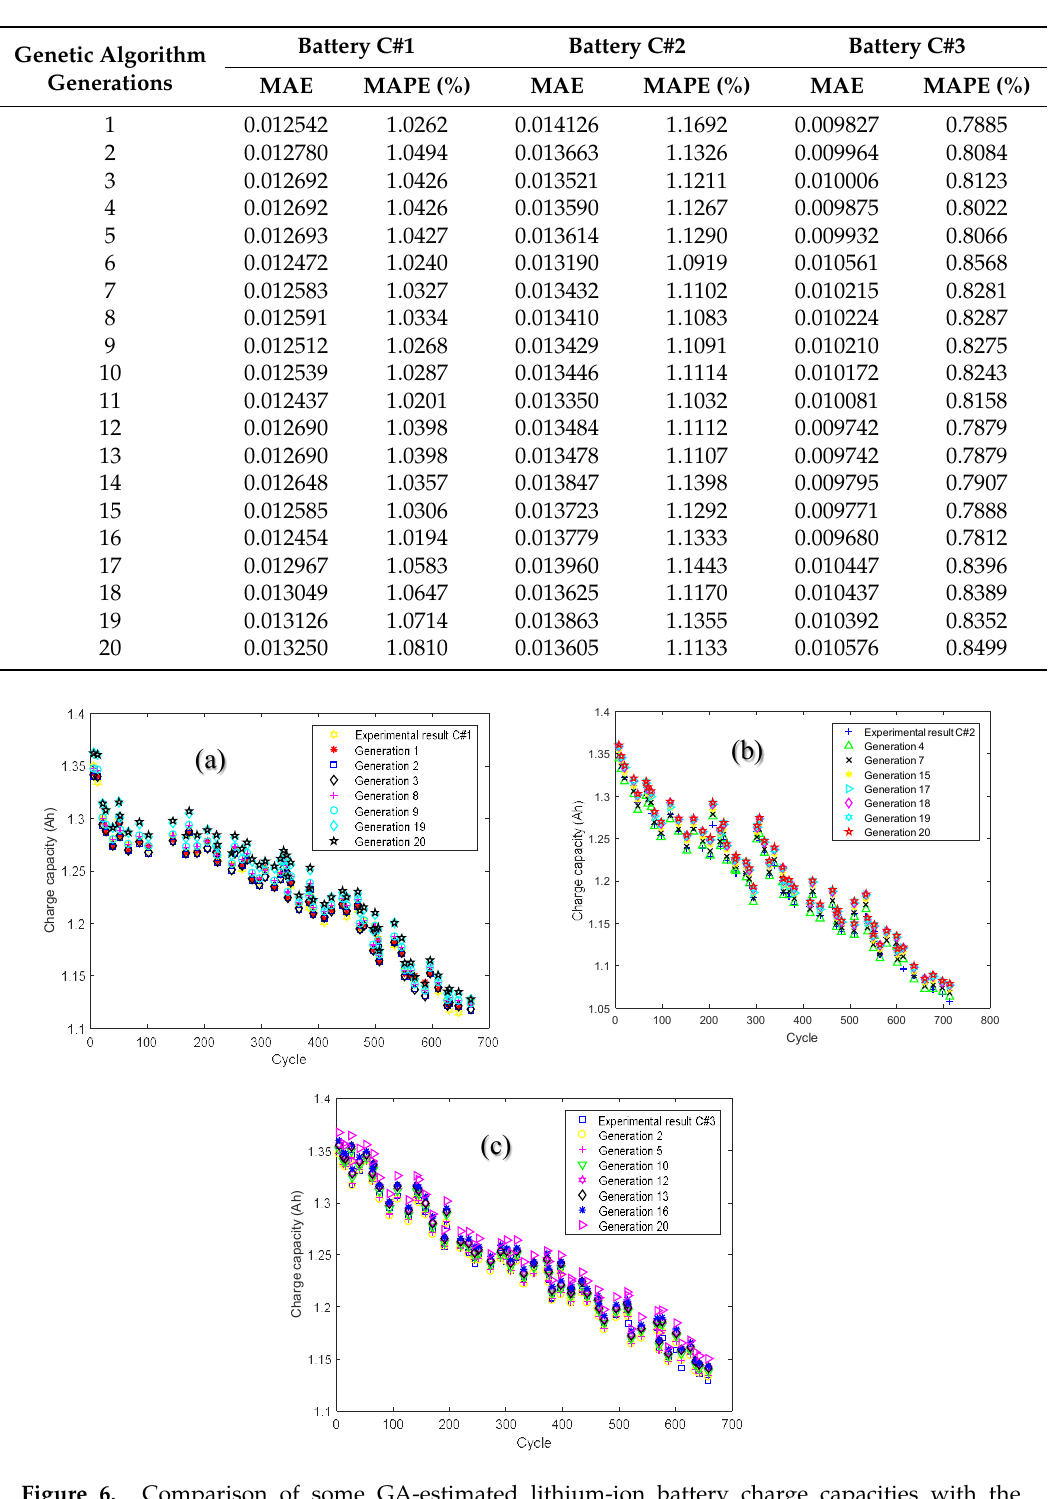
Table 1. Summary of the difference between the GA estimated charge capacities and the experimental results as determined with the mean absolute error (MAE) and mean absolute percentage error (MAPE) at the 80:20 TTDP.